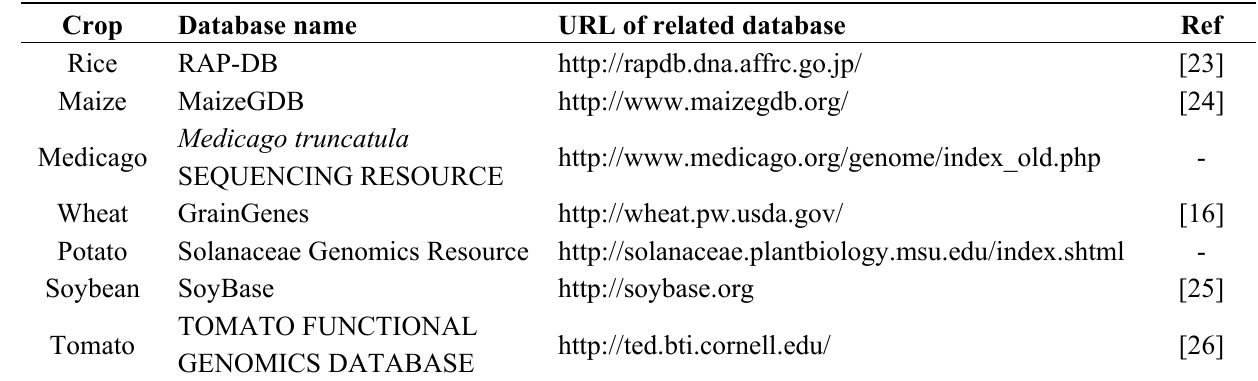
Table 2. Data repositories for crop